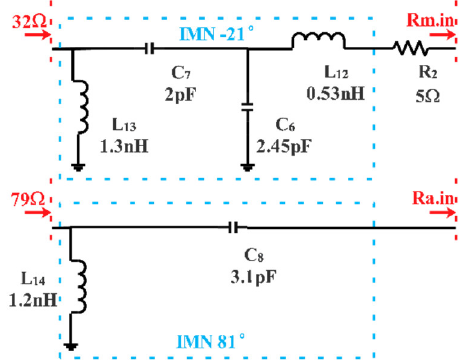
Figure 9. Input matching networks (IMNs) of the proposed DPA.